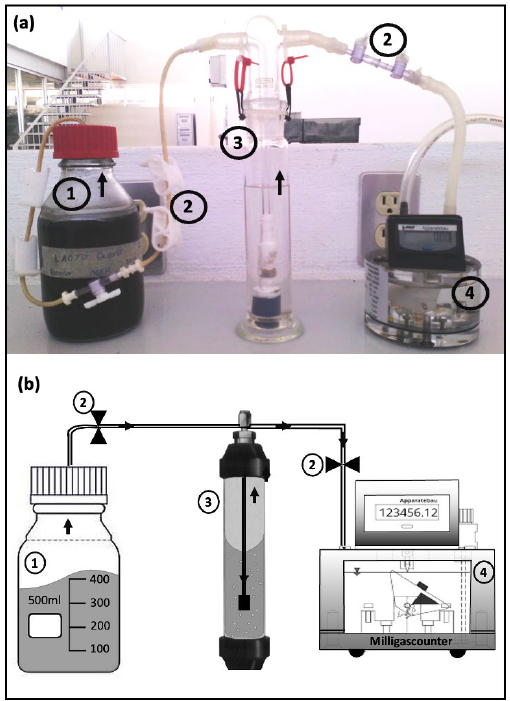
Figure 1. ( a ) Original experimental setup and ( b ) schematic diagram of the AD system. (1) Anaerobic batch bioreactor, (2) safety valves, (3) glass CO 2 trap, (4) RITTER MilliGascounters.